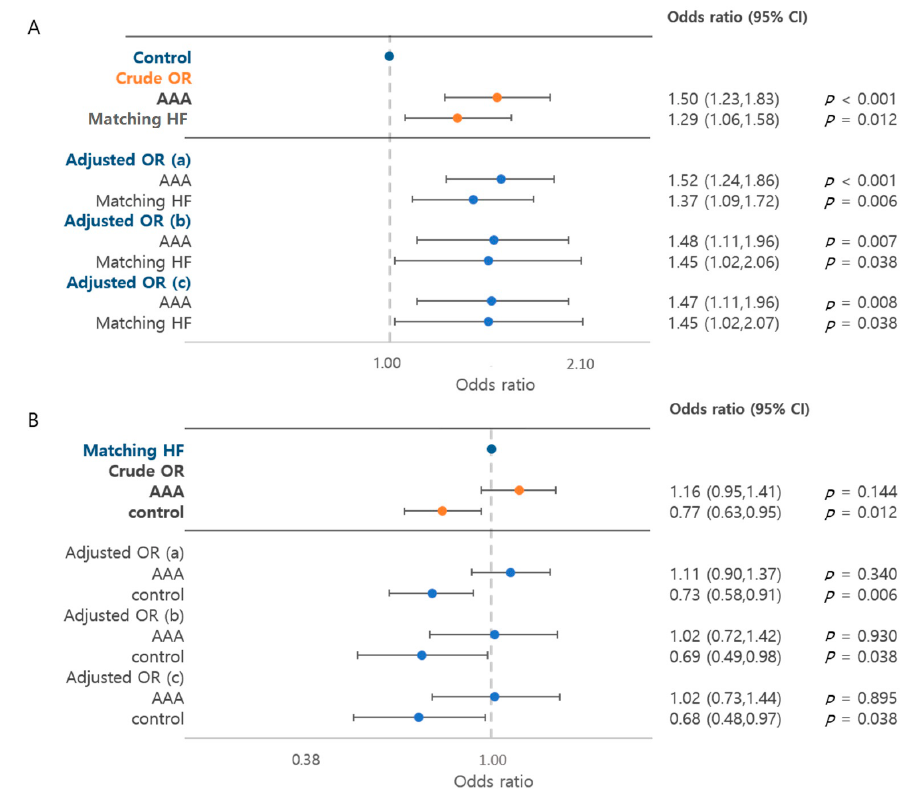
Figure 2. Risk of cancer. ( A ) Control group as a reference. ( B ) Matching HF group as a reference. AAA, abdominal aortic aneurysm; HF, heart failure. (a) Adjusted by hypertension, diabetes, dyslipidemia; (b) adjusted by hypertension, diabetes, dyslipidemia, smoking; (c) adjusted by hypertension, diabetes, dyslipidemia, smoking, alcohol. Table 3. Cancer risk stratified by age groups ( ≥ 50 and < 65 years and ≥ 65 years). AAA Matching HF Patients Matching